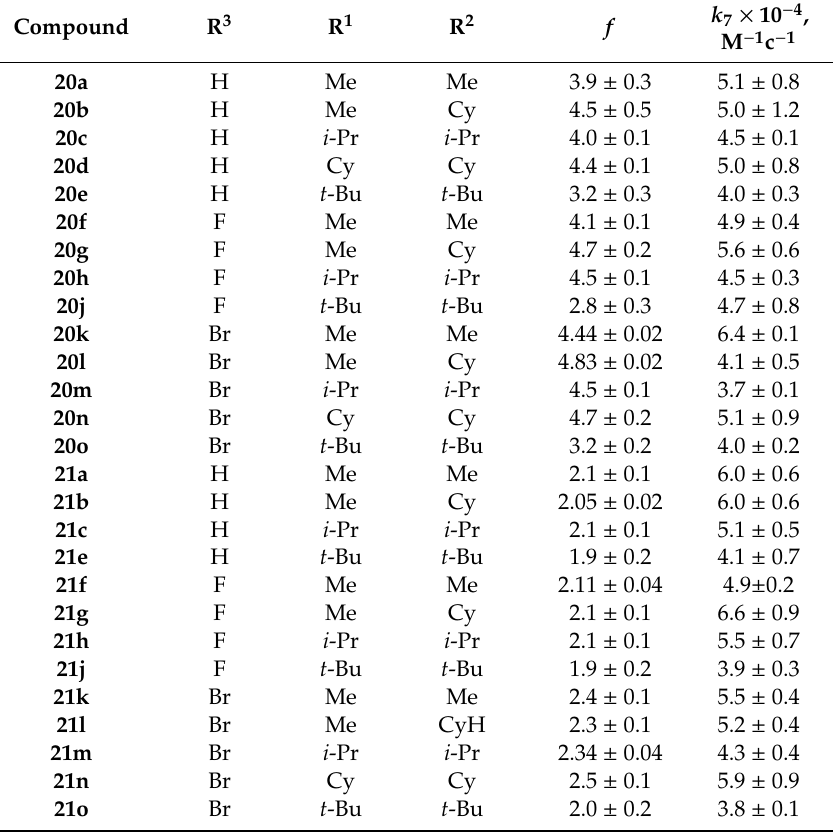
* For comparison, the k 7 constant for 3,5-di b utyl-4- h ydroxy t oluene (BHT) in this model system is 3.1 × 10 4 M − 1 • s − 1